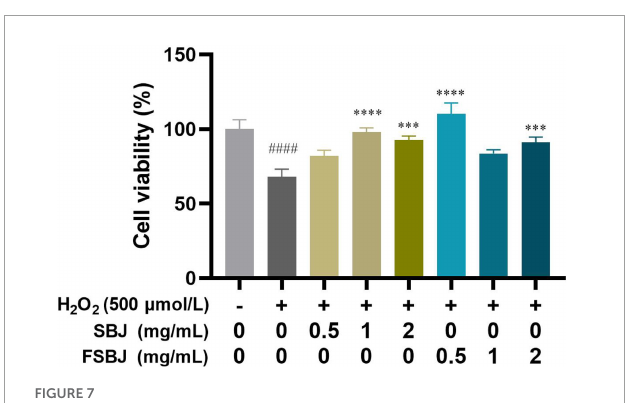
FIGURE7 The effects of SBJ and FSBJ on the survival rates of C2C12 cells exposed to 500 µ mol/L H 2 O 2 compared to the control group